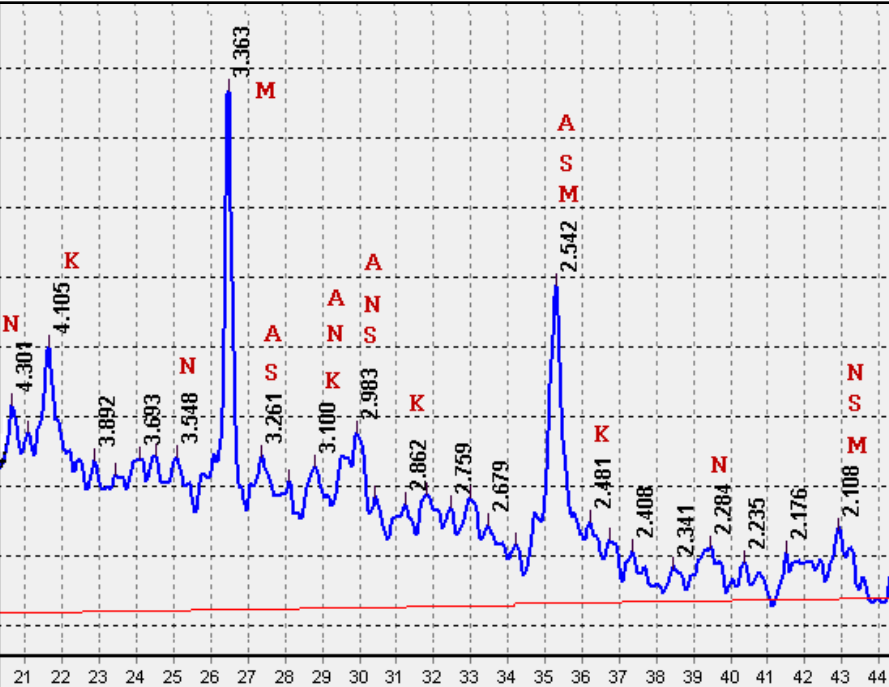
Figure 12. XRD pattern of the CB31 mixture fired at a temperature of 750 ◦ C: M—mullite; K—